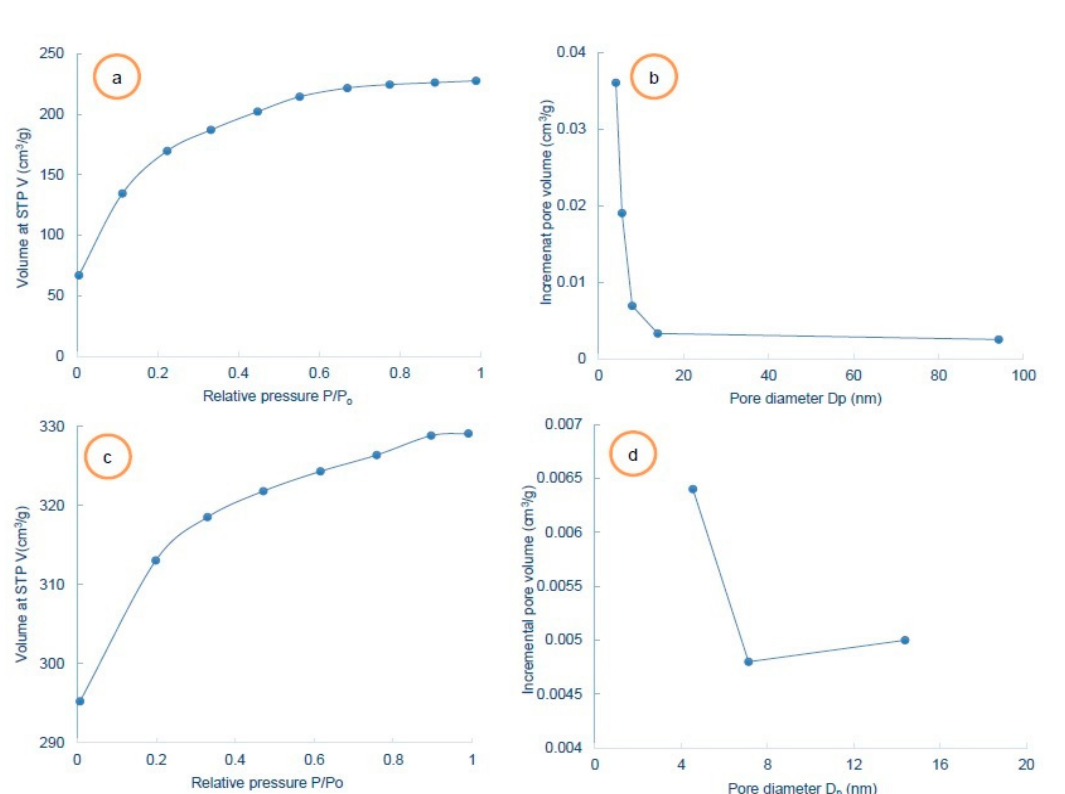
Figure 3. N 2 adsorption isotherms and pore size distribution ( a ) experimental N 2 adsorption isotherm for SG, ( b ) BJH pore size distribution for SG, ( c ) experimental adsorption isotherm for AC and ( d ) BJH pore size distribution for AC.